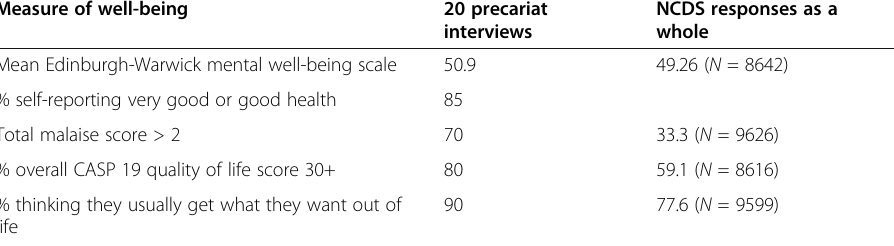
Table 2 Disadvantaged at sample compared to NCDS population as a whole Measure of